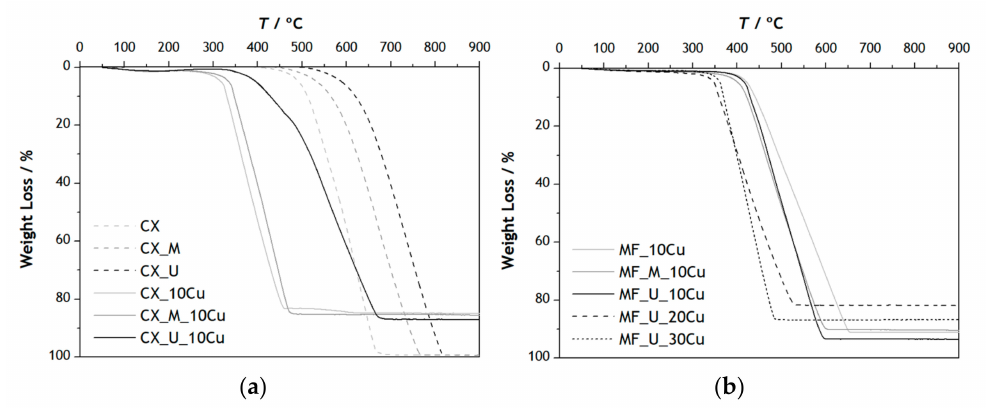
Figure 1. Weight loss during thermogravimetric analysis of ( a ) CX and ( b )